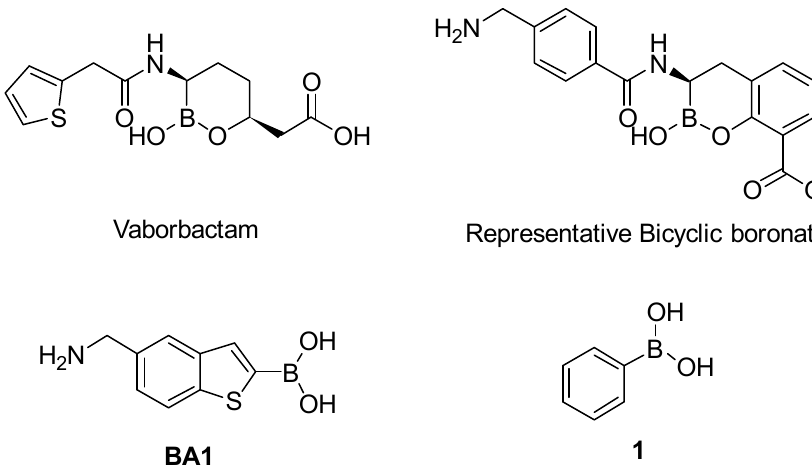
Figure 1. Chemical structures of Vaborbactam [16,17], a representative bicyclic boronate [18], acyclic boronic acid derivative BA1 [21,22] and phenylboronic acid 1 [24].